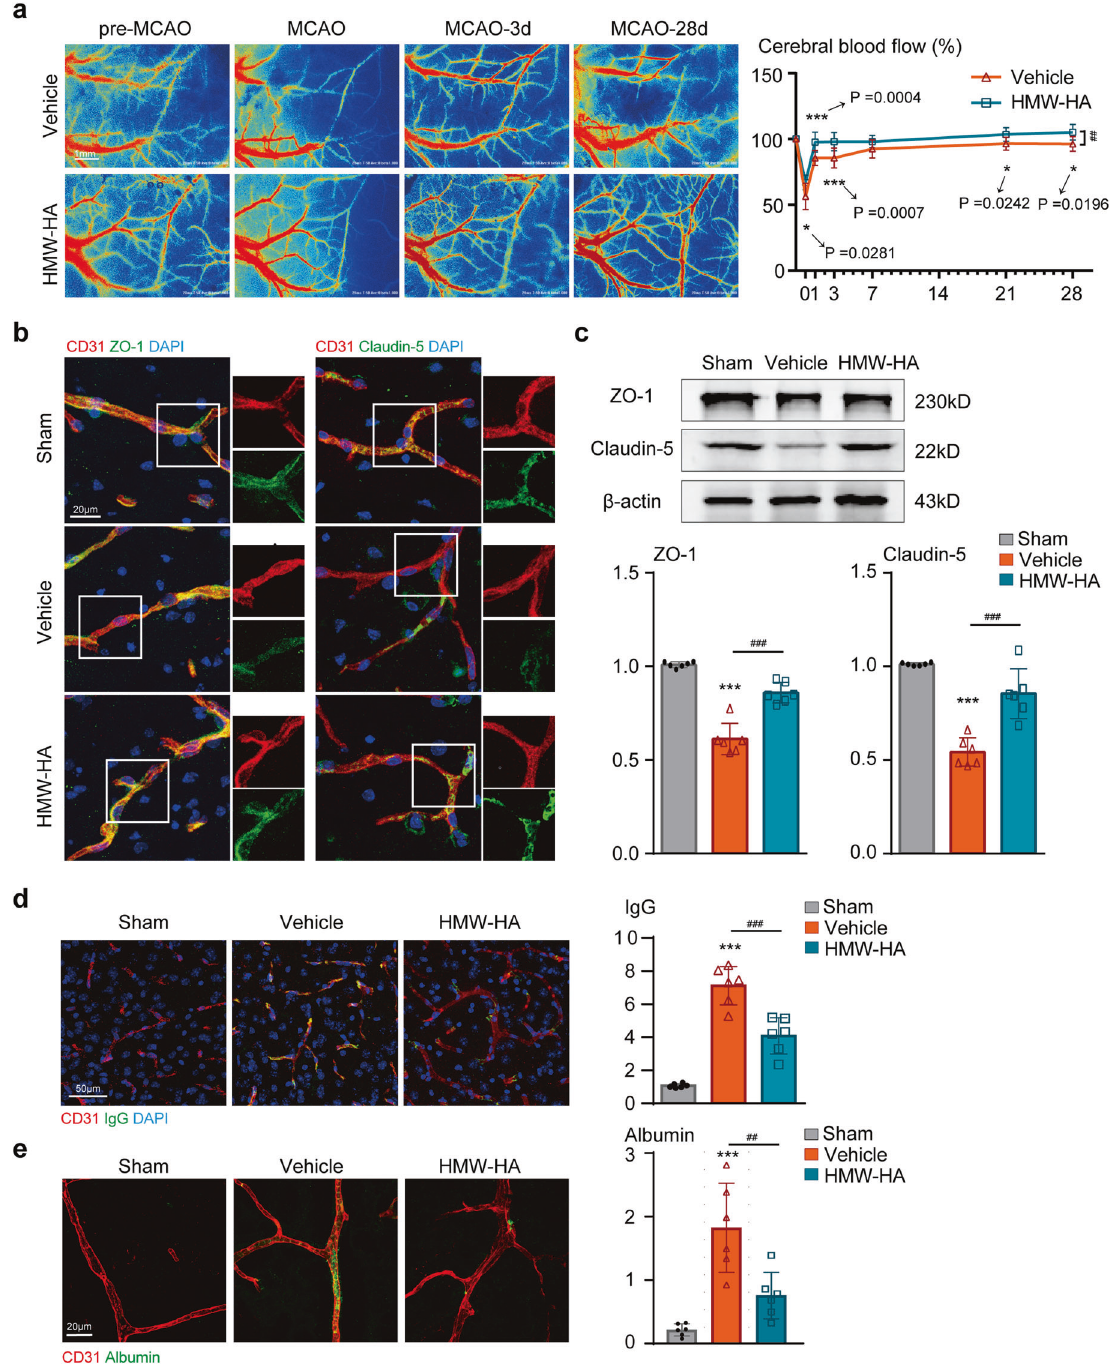
Fig. 3 Suppression of FSAP by HMW-HA treatment improves cerebral blood fl ow recovery in mice after cerebral ischemia. a Representative CBF images were shown at pre-MCAO, and 15 min, 3, 28 days after MCAO. Quantitative analysis of the relative CBF which was fi rst determined as the ratio of ischemic to non-ischemic values, and then normalized to the pre-MCAO baseline for each animal. Data is expressed as mean ±SD; n = 6 – 12 for each group; * p <0.05, *** p <0.001 versus vehicle group by one-way ANOVA followed by Tukey ’ s multiple comparison tests (individual time point); ## p < 0.01 between vehicle and HMW-HA groups by two-way ANOVA with repeated analysis. b , c Blood-brain barrier structure was measured and quanti fi ed by immunostaining and Western blot. b Representative ZO-1 (green) and CD31 (red) immuno fl uorescent images, representative Claudin-5 (green) and CD31 (red) immuno fl uorescent images, and c representative western blot images and quantitative analysis in vehicle group and HMW-HA group at 3 days following MCAO. Data is expressed as mean ± SD; n = 6 for each group; *** p <0.001 versus Sham group, ### p <0.001 versus vehicle group by one-way ANOVA followed by Tukey ’ s multiple comparison tests. d , e Blood-brain barrier leakage was detected and quanti fi ed by extravasated IgG or albumin (green) and CD31 (red) immunostaining in the penumbral regions at 3 days after MCAO. Representative immunostaining images and quantitative analysis of IgG intensity ( d ) and albumin ( e ). Data is expressed as mean ±SD; n = 6 for each group; *** p < 0.001 versus Sham group, ### p < 0.001, ## p <0.01 versus Vehicle group by one-way ANOVA followed by Tukey ’ s multiple comparison tests